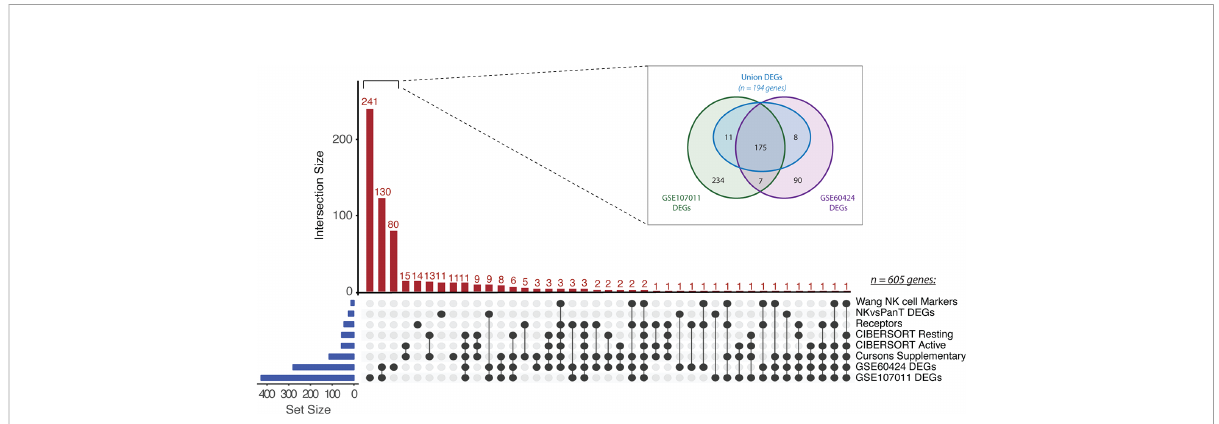
FIGURE 1 Collation of putative NK cell signature genes. UpSet plot of gene intersects from eight partially overlapping sources (listed at right). Gene set (blue bars) and intersection (red bars) sizes are indicated. Inset: Venn diagram of DEGs identi fi ed from pairwise comparisons of NK cells versus other immune cell types in GSE60424 and GSE107011. Only the “ Union DEGs ” (n genes = 194) were retained as candidate signature